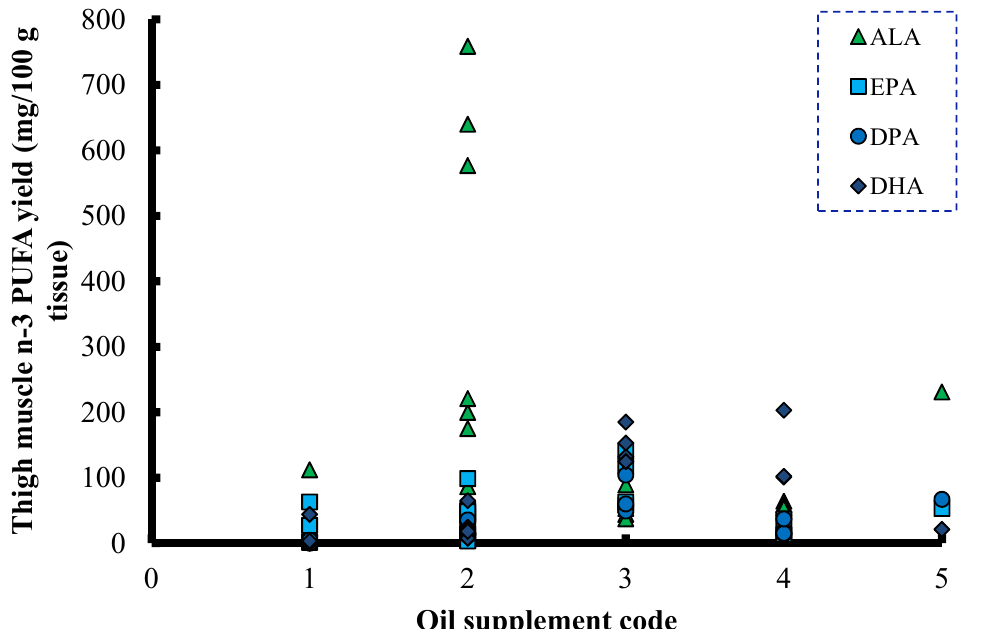
Figure 3. Levels of omega-3 PUFA (ALA) and omega-3 LC-PUFA (EPA, DPA and DHA) in thigh muscle from broilers on a diet with: (1) no oil supplement; (2) vegetable oil; (3) fish oil; (4) marine algae; or (5) SDA-containing oil